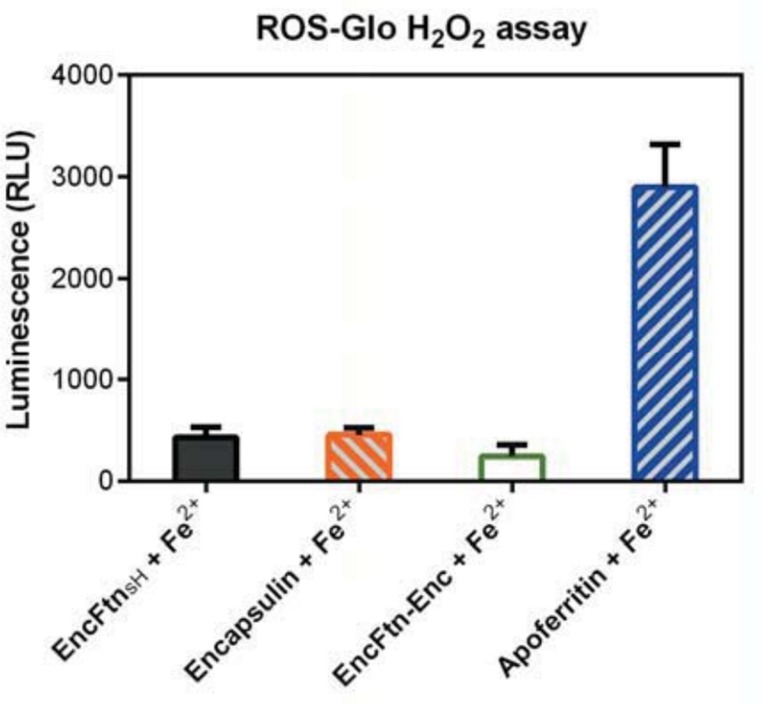
DOI:
http://dx.doi.org/10.7554/eLife.18972.037